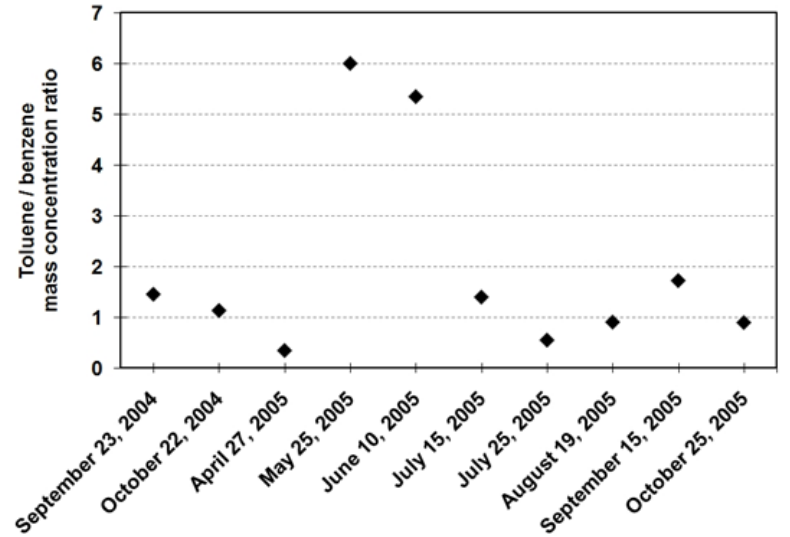
Figure 3. Average daily ratio of mass concentrations of toluene and benzene for the measuring period at Mali Lošinj.